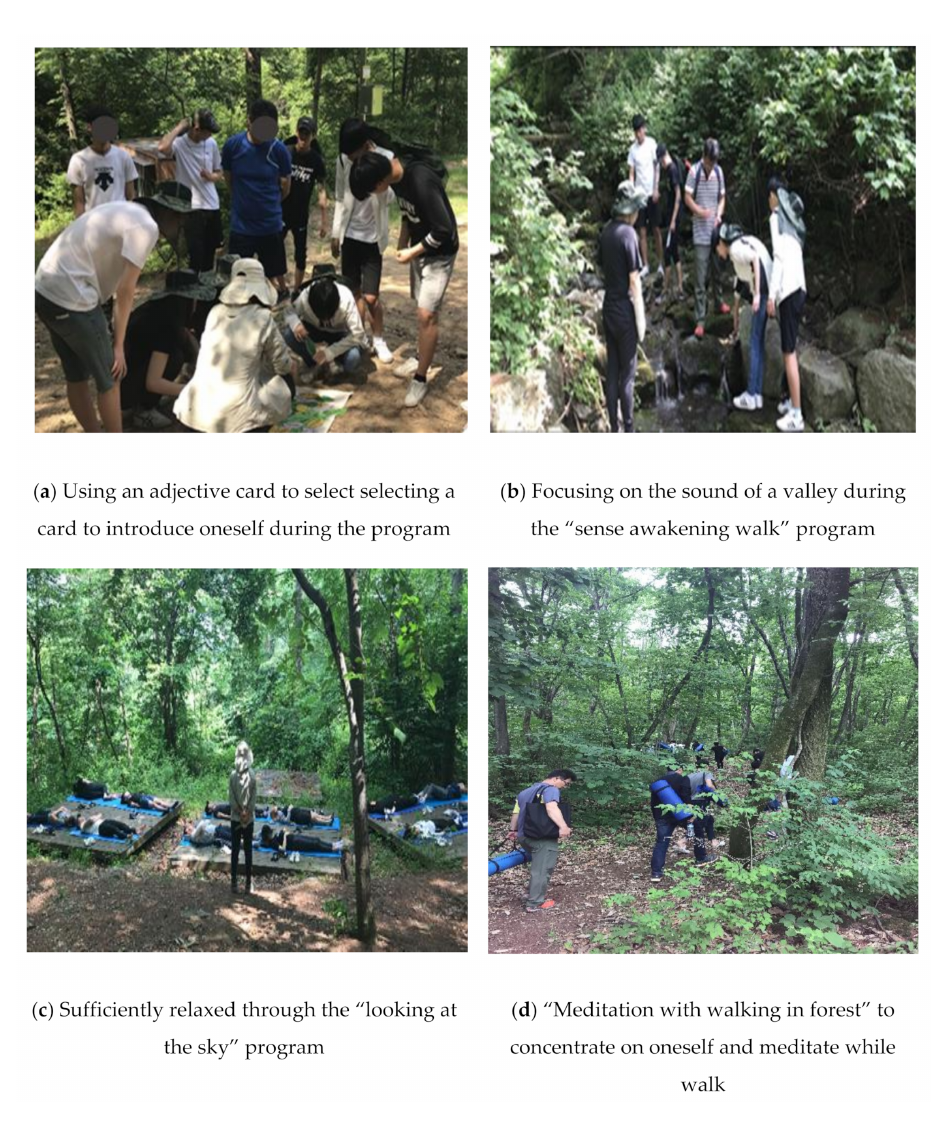
Figure 2. Major progress of forest therapy